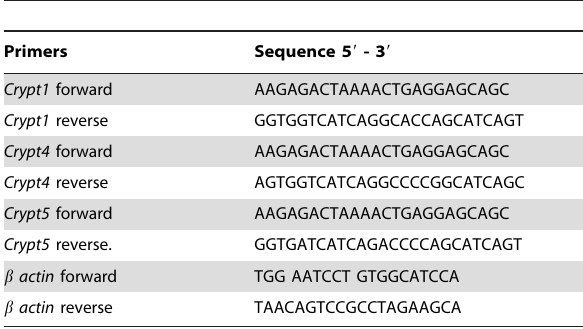
Table 5. List of primers used for semi-quantitative RT-PCR of cryptdine